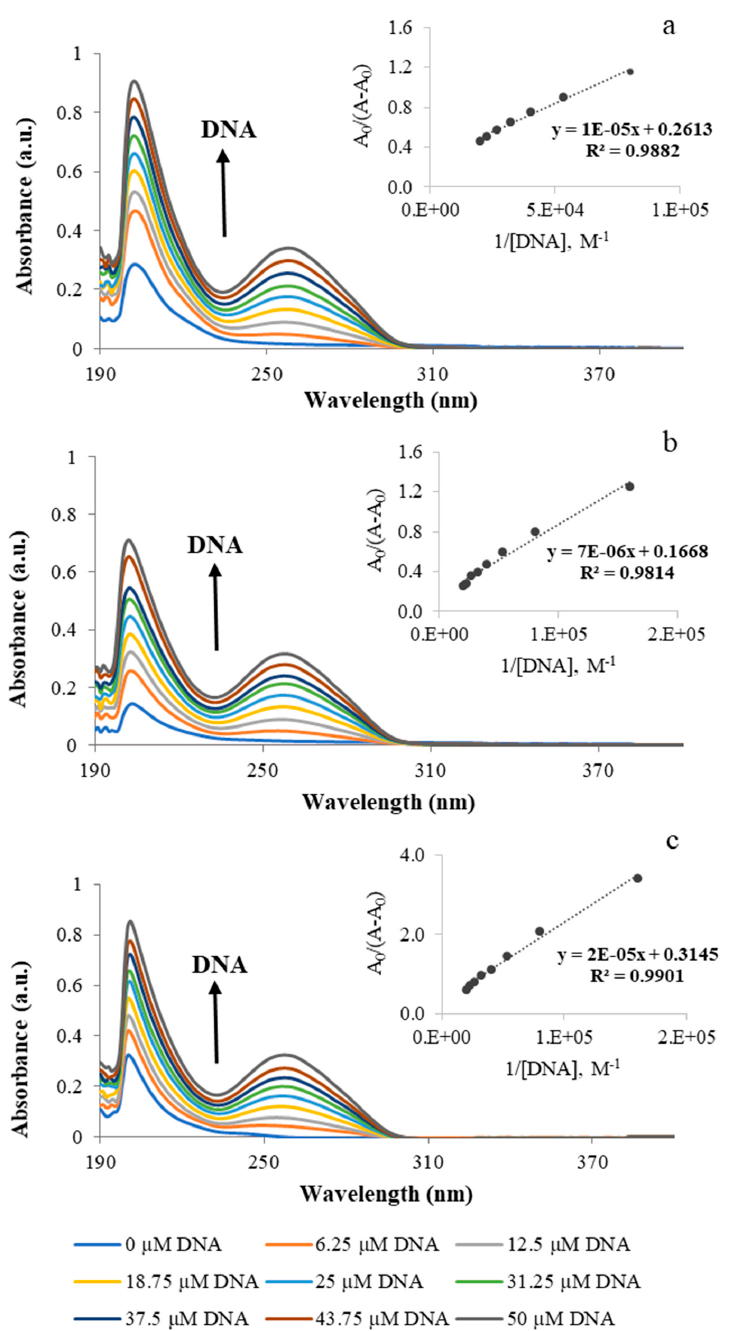
Figure 1. Representative UV-visible spectra of ( a ) monodentate G0.5COO(Pt(NH 3 ) 2 Cl) 8 , ( b ) monodentate G2.5COO(Pt(NH 3 ) 2 Cl) 32 , and ( c ) bidentate G2.5COO(Pt(NH 3 ) 2 ) 16 with increasing concentration of CT-DNA (0, 6.25, 12.5, 18.75, 25, 31.25, 37.5, 43.75, and 50 µM) in 5 mM Tris-HCl/50 mM NaCl at pH 7.4. The inset corresponds to the plot of A 0 /(A − A 0 ) versus 1/[DNA], used to determine the binding constant. The arrow indicates the direction of increasing the concentration of DNA.